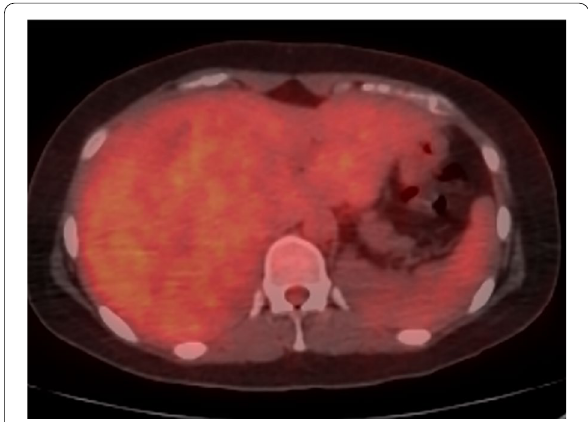
Fig. 2 18F-fluorodeoxyglucose positron-emission tomography (FDG-PET) finding. FDG-PET showed slightly high FDG uptake of the tumor (SUVmax 2.7). FDG 2-fluoro-2-deoxy-d-glucose, SUVmax = maximum standard unit